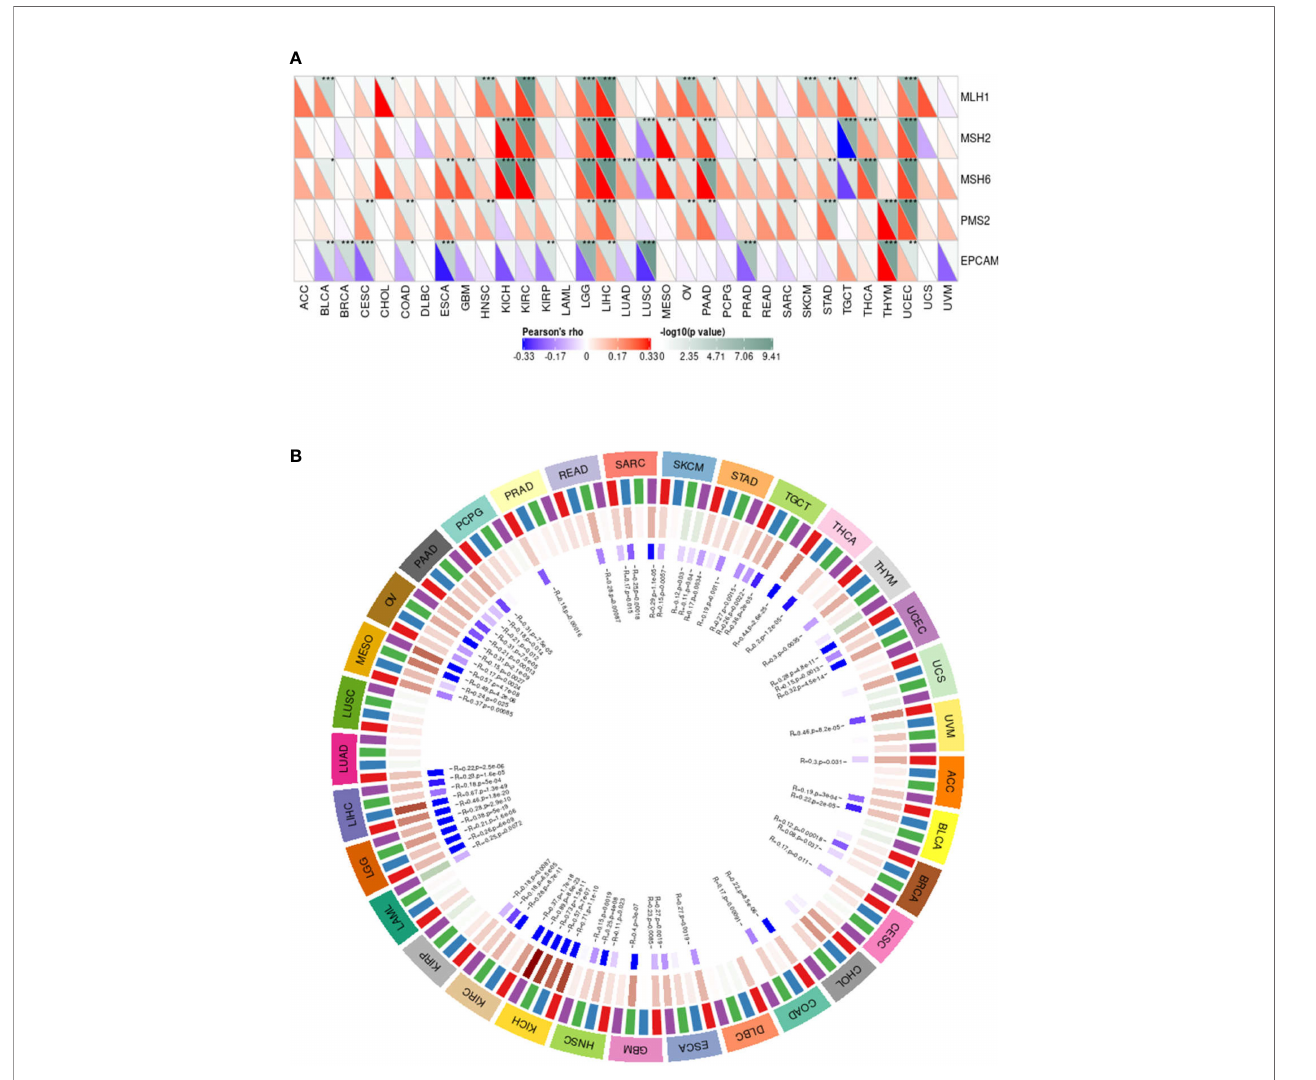
FIGURE 11 | The expression of matrix metalloproteinase 14 (MMP14) was correlated with the expression of fi ve mismatch repair (MMR) genes and four DNA methyltransferases. (A) Spearman correlation analysis was used to analyze the correlation between MMR gene expression and MMP14 expression in tumors (*p < 0.05, **p < 0.01, **p < 0.001). (B) Spearman correlation analysis was used to analyze the correlation between four DNA methyltransferases and MMP14